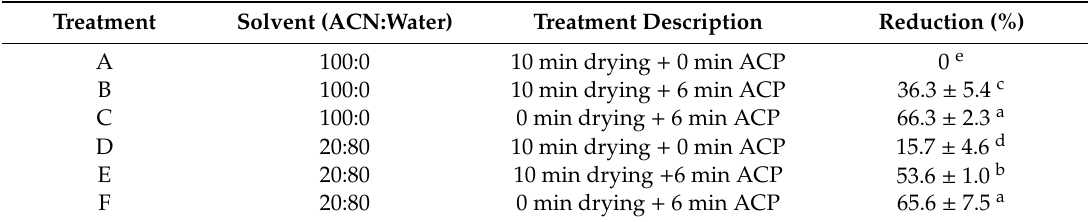
Table 5. E ff ect of solvent type and treatment conditions (drying time and ACP treatment time) on degradation of DON on steeped barley grains by